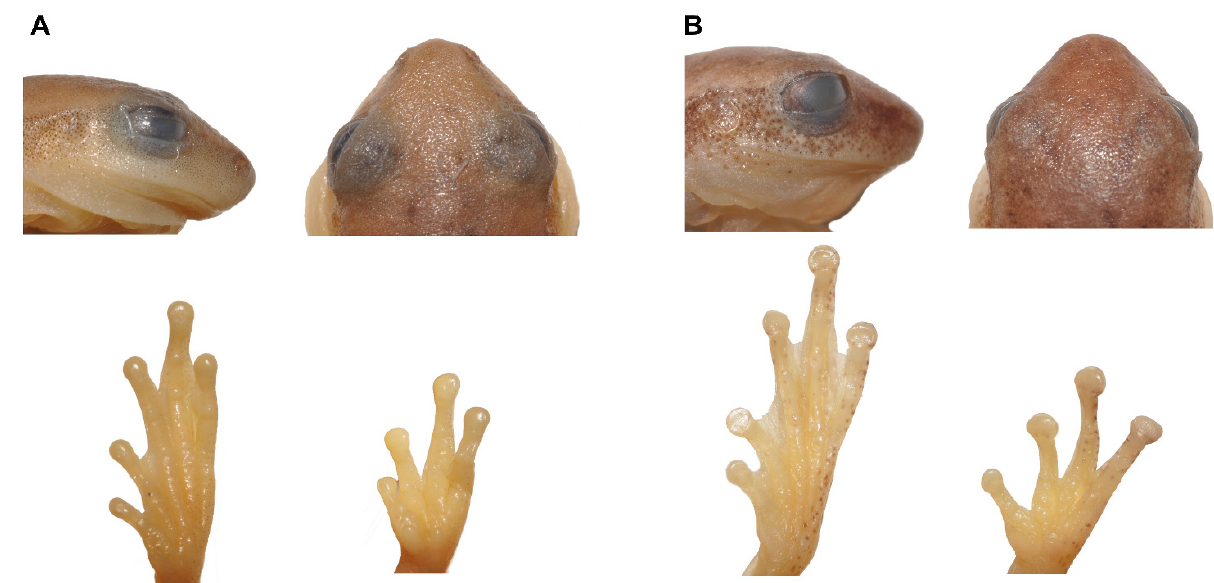
Figure 4. Morphological characteristics of preserved topotypes of Dendropsophus nanus ( A ) and Dendropsophus walfordi ( B ). Lateral and dorsal views of the head ( top ); palmar and plantar views of the foot and the hand ( bottom ) of topotypes of D. nanus (UNEC 12429) and D. walfordi (AAG-UFU 5311).